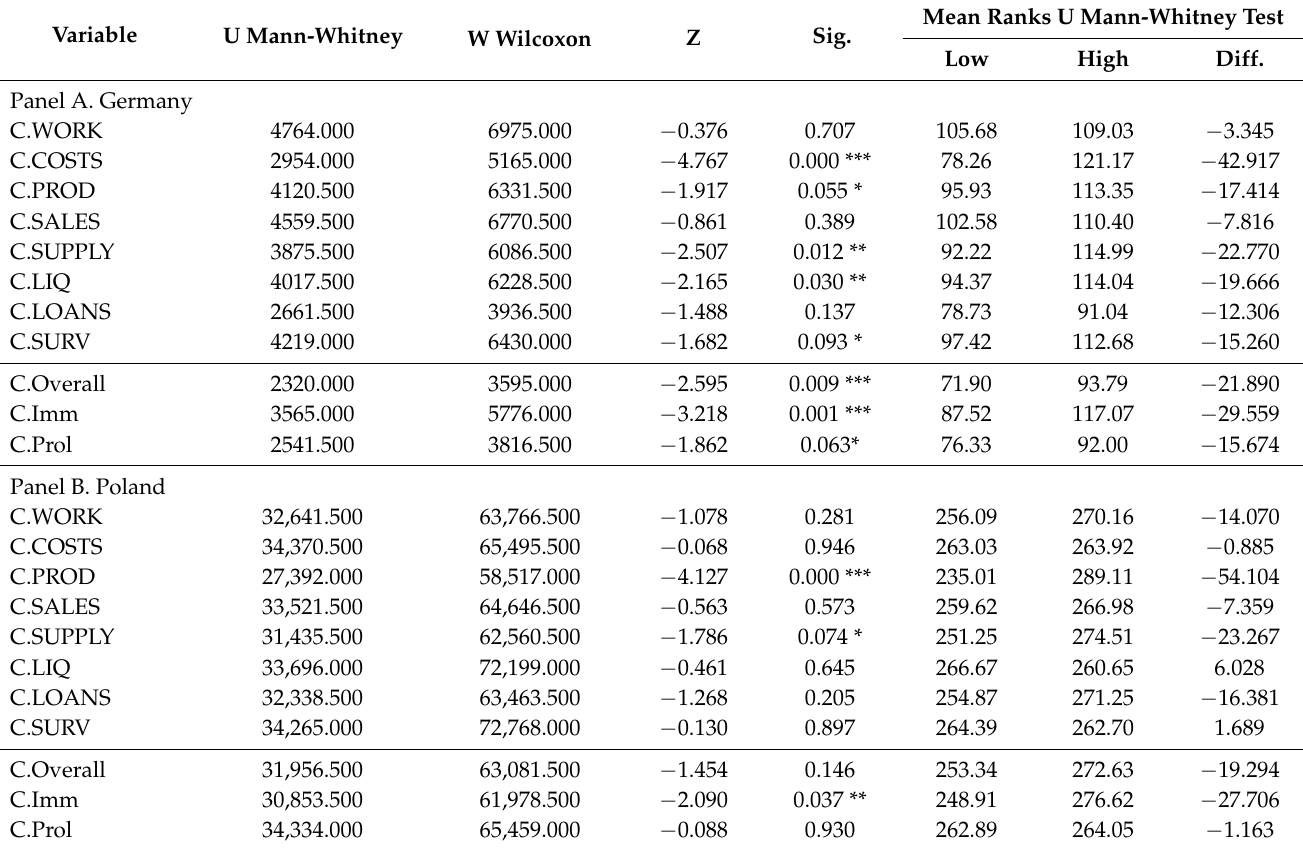
Table 9. Results of U Mann-Whitney test for the perceptions of COVID-19 impacts and the ERM sophistication (group of low vs. high ERM